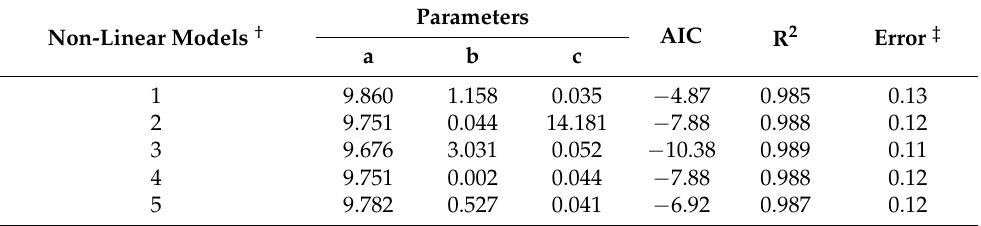
Table 2. Estimated biological parameters, values of Akaike’s information criterion (AIC), coefficient of determination, and absolute error of the adjusted models for the estimation of water disappearance in the growing–finishing phase, according to the pigs’ body weight.